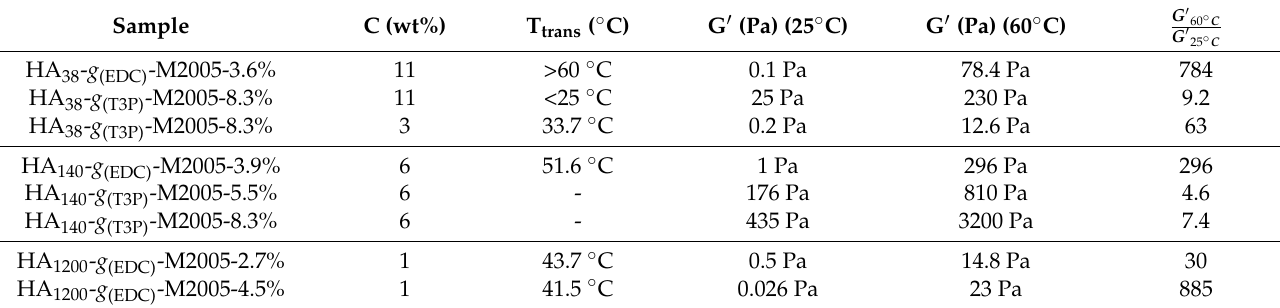
Figure 5. Rheological profile of ( a ) HA 1200 - g (EDC) -M2005-4.5% at 1 wt% in water and ( b ) HA 1200 - g (EDC) -M2005-2.7% at 1 wt% in water. Heating ramp: G (cid:48) (blue square), G (cid:48)(cid:48) (red rhombus), η * (green triangle) vs temperature; measurement in oscillation mode (parameters: shear stress: 0.1 Pa; frequency: 1 Hz; rate: 0.5 ◦ C.min − 1 ). Table 3. Rheological properties of the different HA- g -M2005